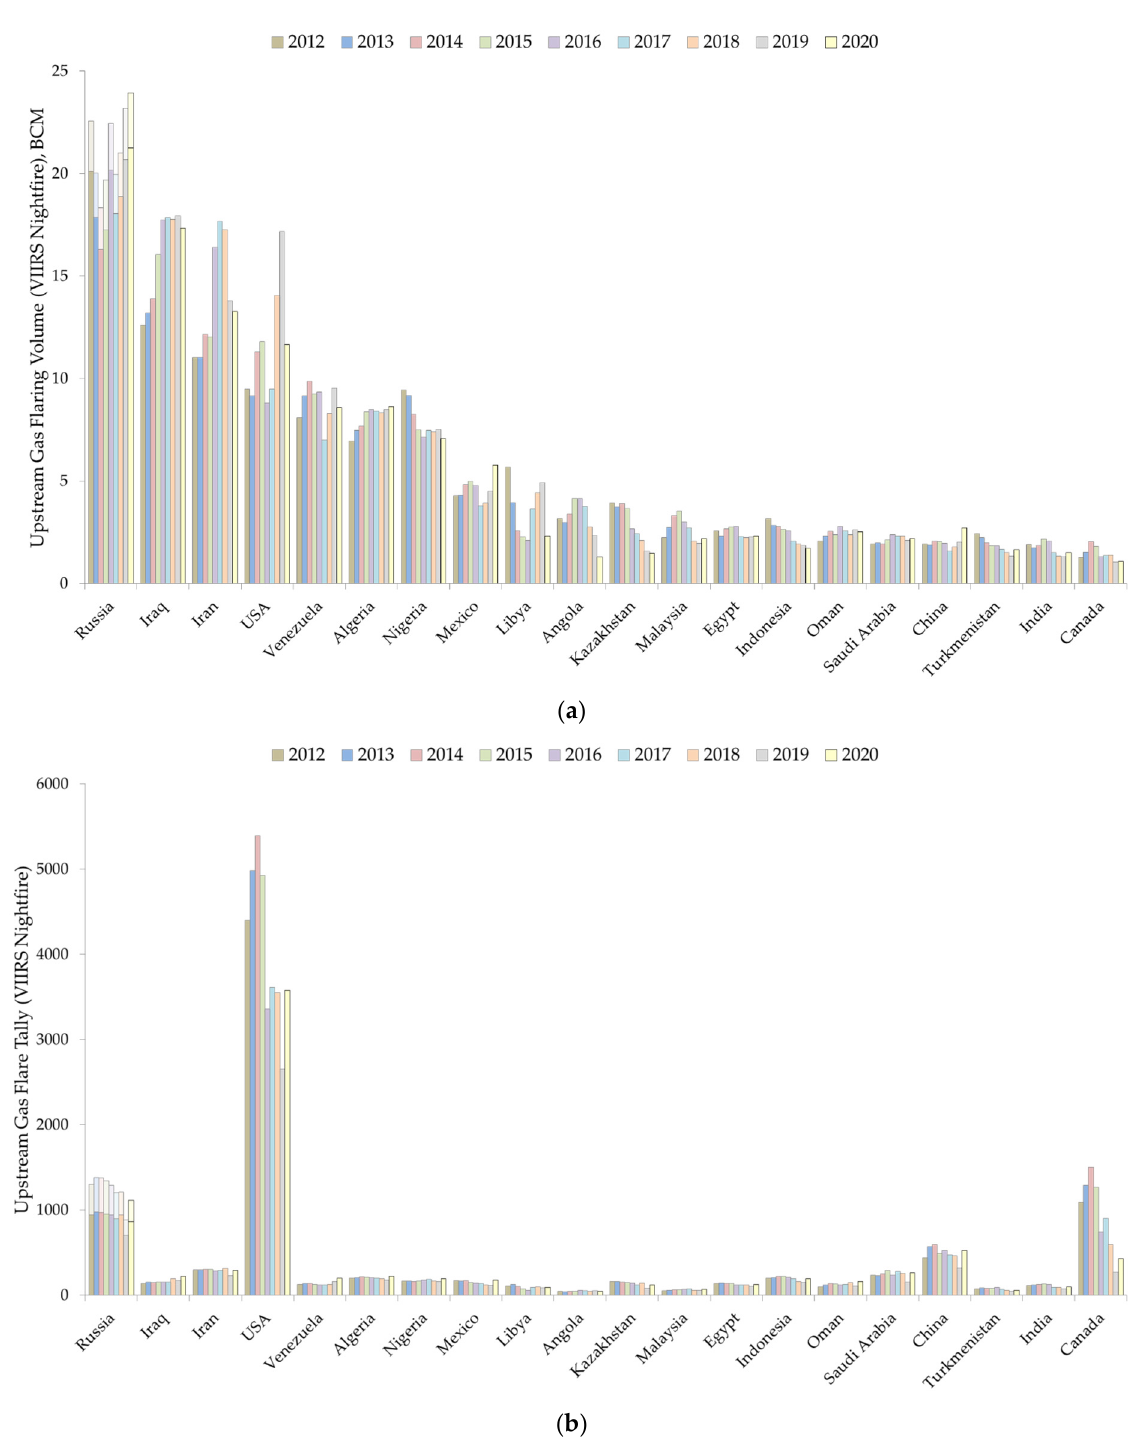
Figure 4. Histogram VIIRS Nightfire-estimated top 20 upstream gas flaring countries in 2012–2020 as per ( a ) gas flaring volumes (in BCM) and ( b ) gas flare tally. Shaded area for Russia represents the natural gas upstream sector.